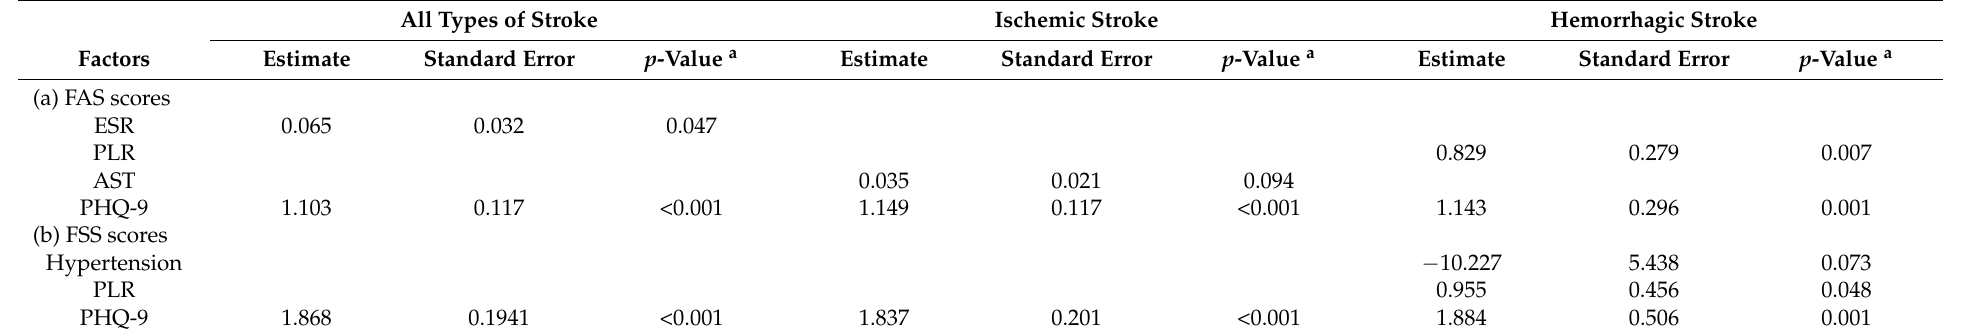
Table 5. Results of multiple linear regression model for post-stroke